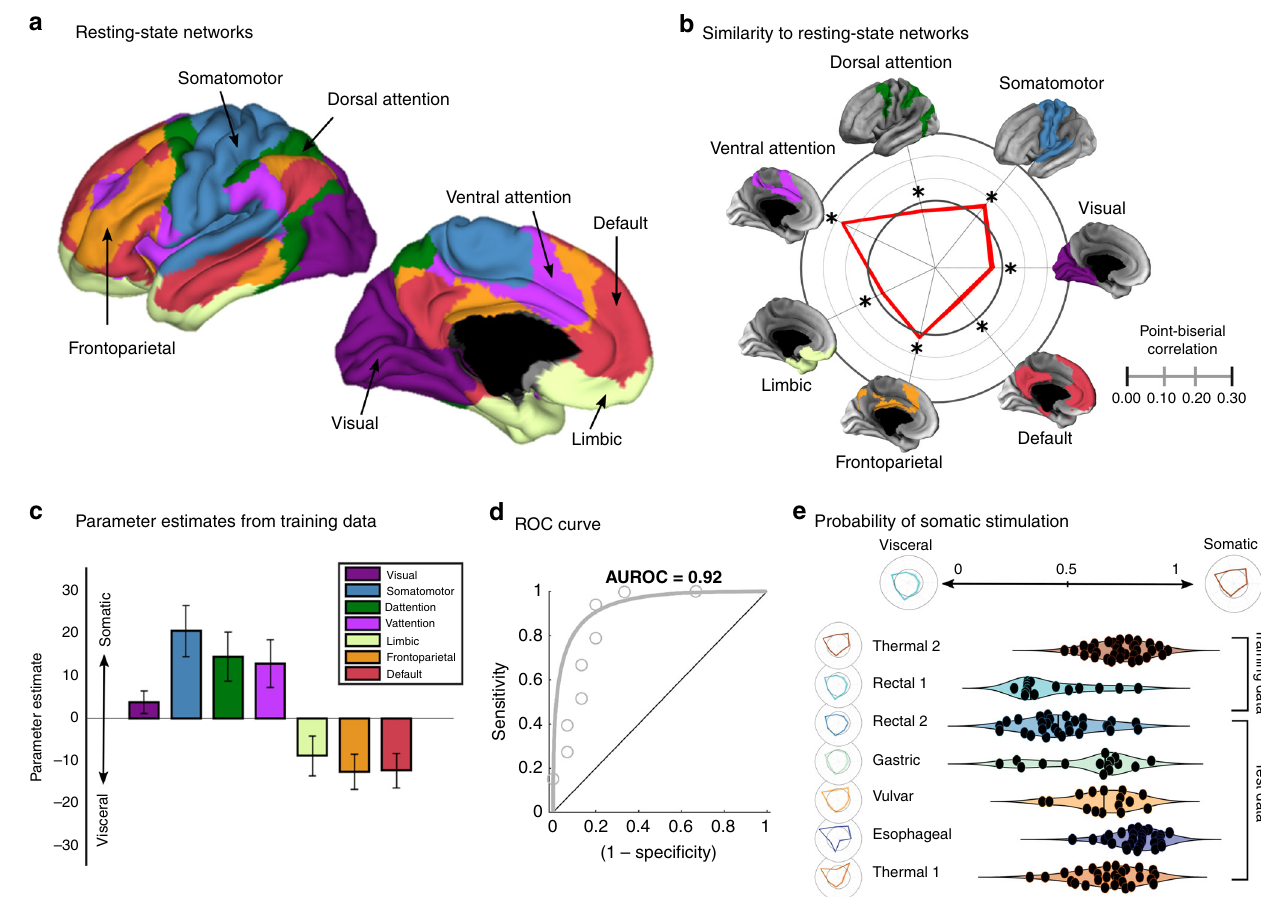
Fig. 5 Classi fi cation of brain responses based on point-biserial correlations with resting-state networks. a A visual depiction of the resting-state networks based on data from 1000 subjects 33 . b Point-biserial correlations between pooled brain responses (both somatic and visceral studies) and the seven resting-state networks. The inner bold line is the zero point, and values inside the inner circle re fl ect negative correlations. c Parameter estimates from a logistic regression model predicting whether brain responses were observed during visceral (rectal; N = 15) or somatic (cutaneous; N = 33) stimulation. Error bars re fl ect the standard error of the mean. * P < 0.05, two-tailed, one-sample t tests. d The Receiver Operating Characteristic (ROC) curve shows cross-validated performance on the training datasets (AU = area under the curve = 0.92). The solid line shows a Gaussian model fi t. e Generalization tests show the probability of data from novel subjects as being classi fi ed as somatic or visceral. Scores for the training datasets were estimated using cross-validation. Test data scores apply the model prospectively, with no parameter adjustment. Each circle indicates the prediction for a single subject. Polar plots depict spatial similarity with resting-state networks as in panel ( b ). Each polar plot depicts the average similarity for each study: the rectal and thermal stimulation studies used for training the classi fi er, and the fi ve hold-out studies used to test its generalizability. Source data are provided as a Source Data fi